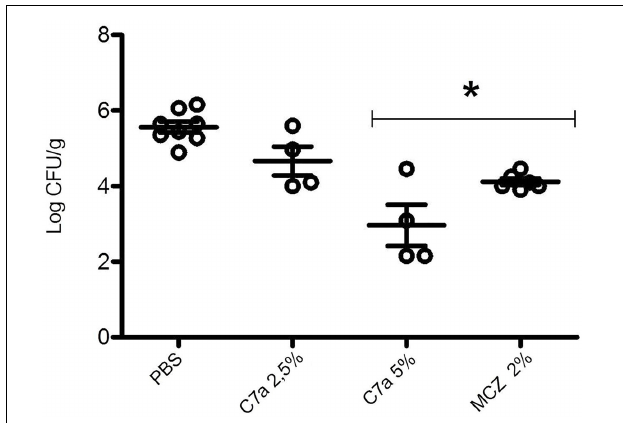
FIGURE 6 | Cyclopalladated C7a treatment of vaginal candidiasis. The vaginal candidiasis was induced by local inoculation of 3 × 10 6 C. albicans ATCC 10231 yeasts suspended in 10 µ L of PBS in BALB/c mice. Animals were treated every 24 h for 7 days with a vaginal cream containing PBS, 2.5% or 5% of C7a, or 2% of MCZ. Treatment was evaluated by determination of the number of colony forming units (CFU) per gram of tissue of the vaginas, 8 days after infection. Animals are represented individually, and 1 representative experiment out of 3 is showed. ∗ Indicates statistical significance (ANOVA with post-Tukey test, P < 0.05) compared to PBS-inoculated